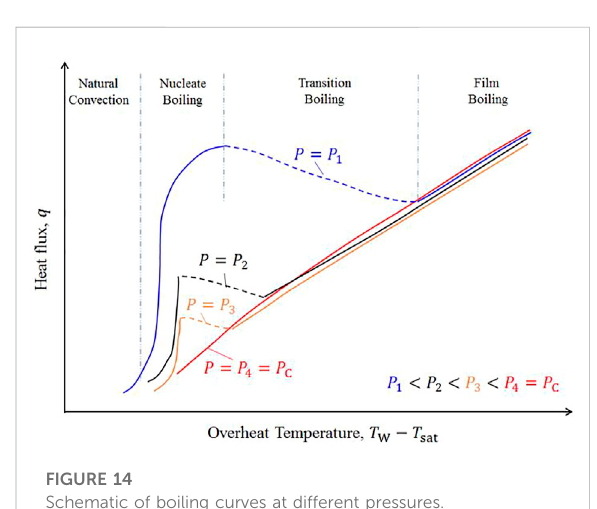
FIGURE 14 Schematic of boiling curves at different